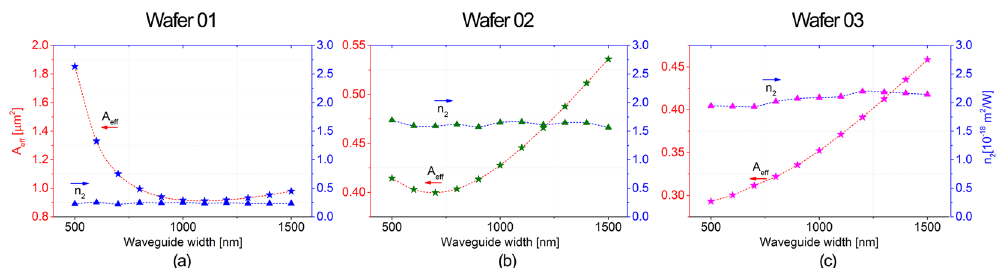
Figure 7. Calculated effective area and calculated n 2 values for each waveguide width for each Si x N y composition.